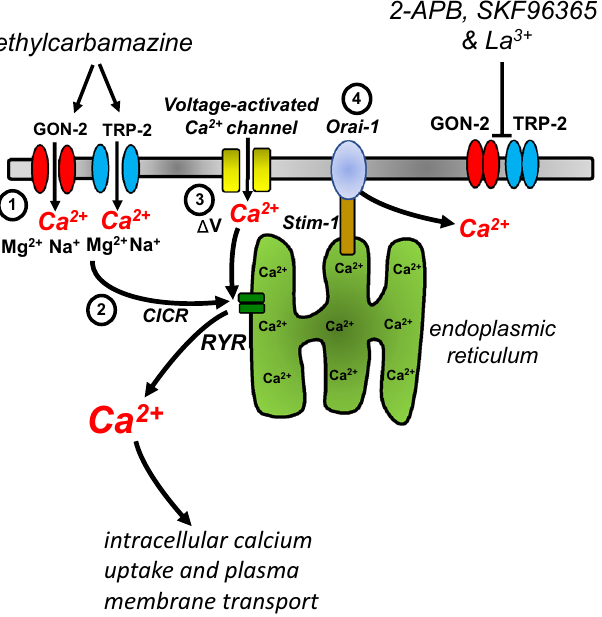
Figure 7. Summary diagram of proposed DEC stimulation of Ca 2+ entry into intestinal cells via TRP channels: Diagram representing the mode of action for DEC in the intestine of ascaris suum . (1). DEC activates the TRPM channel GON-2 (red) and TRPC channel TRP-2 (blue), to promote extracellular Ca 2+ entry. Cation entry can lead to two possible pathways (2) Ca 2+ induced Ca 2+ release (CICR) leading to intracellular storage release via RYR receptors (green). (3) activation of Ca 2+ channels (yellow) on the membrane by changes in membrane potential (ΔV) increasing extracellular Ca 2+ entry. (4) Emptying of the calcium stores in the endoplasmic reticulum activates store-operated entry mediated by STIM1 and Orai-1. 2-APB, SKF96365 and La 3+ can inhibit TRP channels preventing Ca 2+ entry and subsequent Ca 2+ increases. Cytosolic calcium is subsequently taken up in intracellular organelles or removed by exchangers and